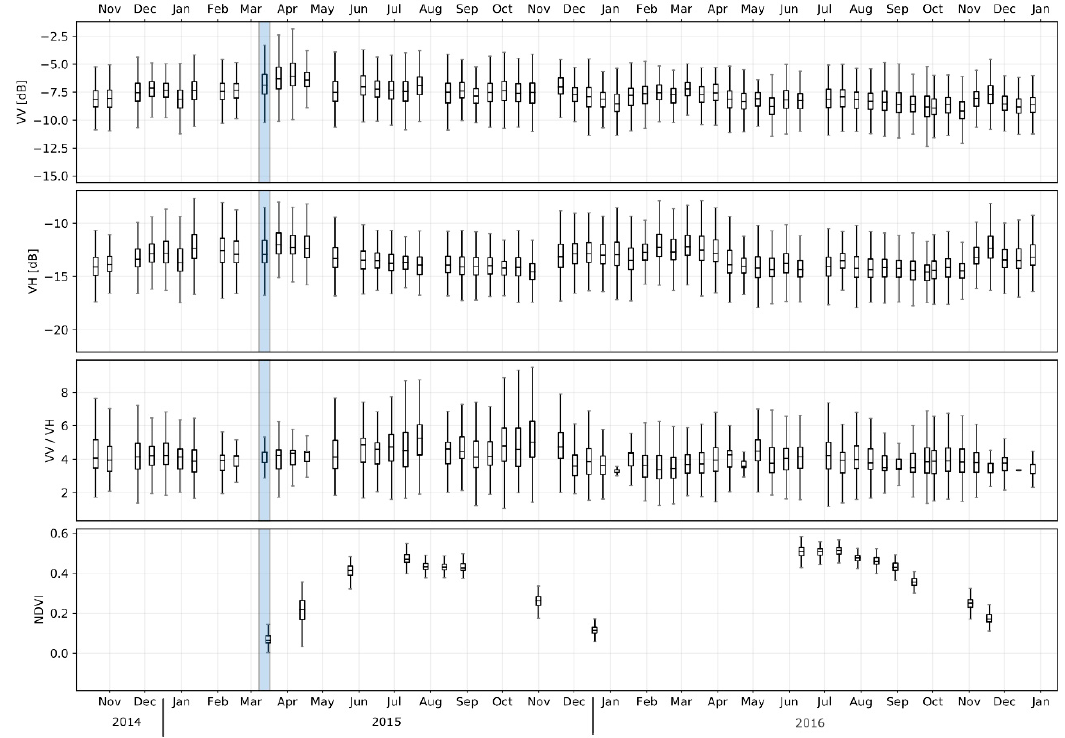
Figure 8. Multitemporal behavior of the backscatter intensity for TFV areas for VV (dB), VH (dB), VV/VH (linear scale), and NDVI values in northern Greece/Turkey. The blue bars mark the analyzed date at the flood event.